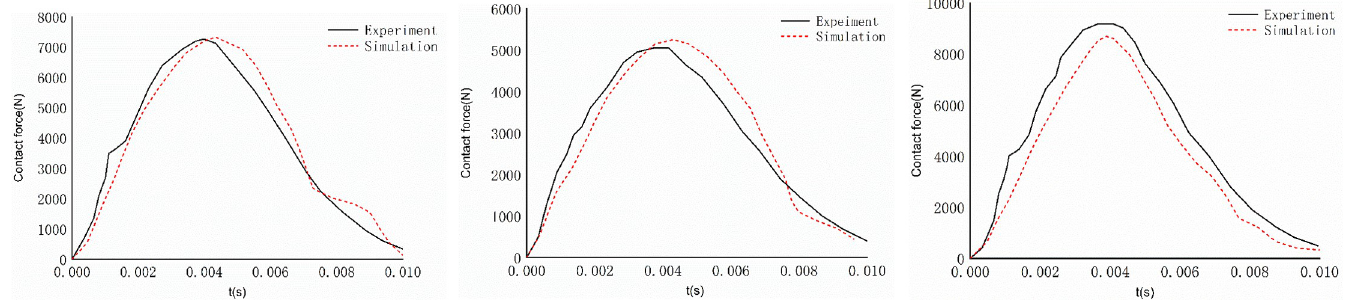
Fig 11. Contact force curve of simulation and cadaver experiment. (A) v = 3.5 m/s. (B) v = 4.9 m/s. (C) v = 6.0 m/s.